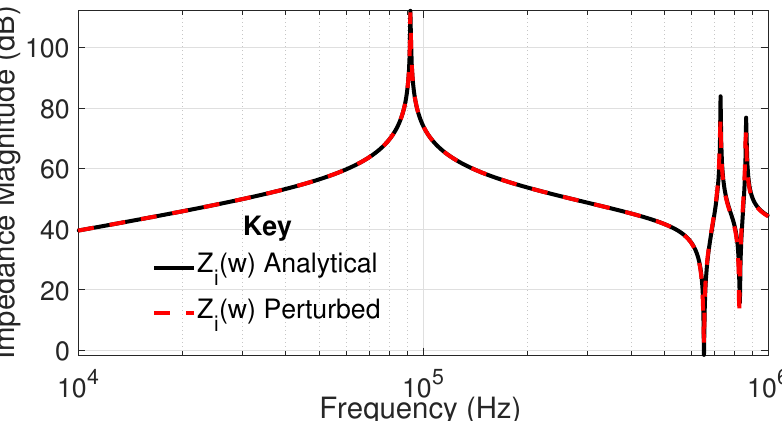
Figure 6. Frequency Responses of the Input Impedance of the Target Model Obtained Analytically and Through Perturbation [28]. (© 2023 IEEE. Reprinted, with permission, from EEEIC/I&CPS